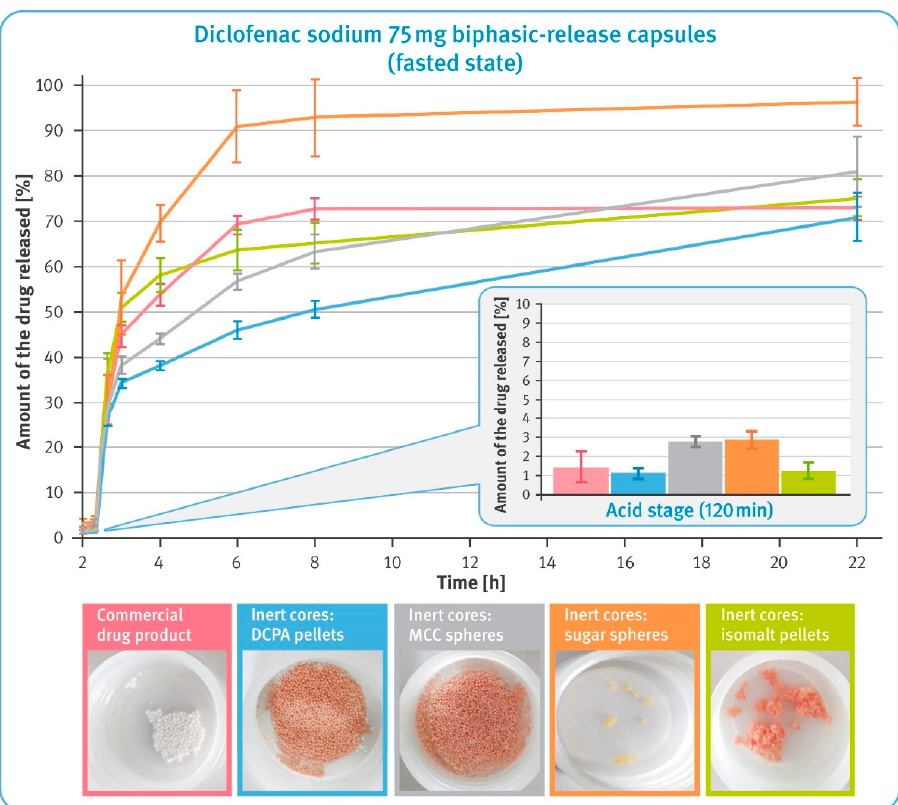
Figure 7. The release of the drug substance from diclofenac sodium 75 mg biphasic-release hard gelatin capsules under conditions simulating pH changes in fasted state in USP apparatus 3 (mean of n = 3, SD is indicated by the error bars). Underneath are residues of diclofenac sodium BPR capsules in tubes after completing the test.